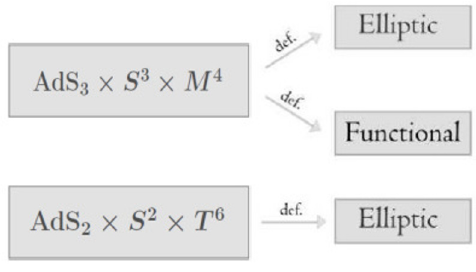
Figure 1 . New deformations of AdS 3 and AdS 2 R